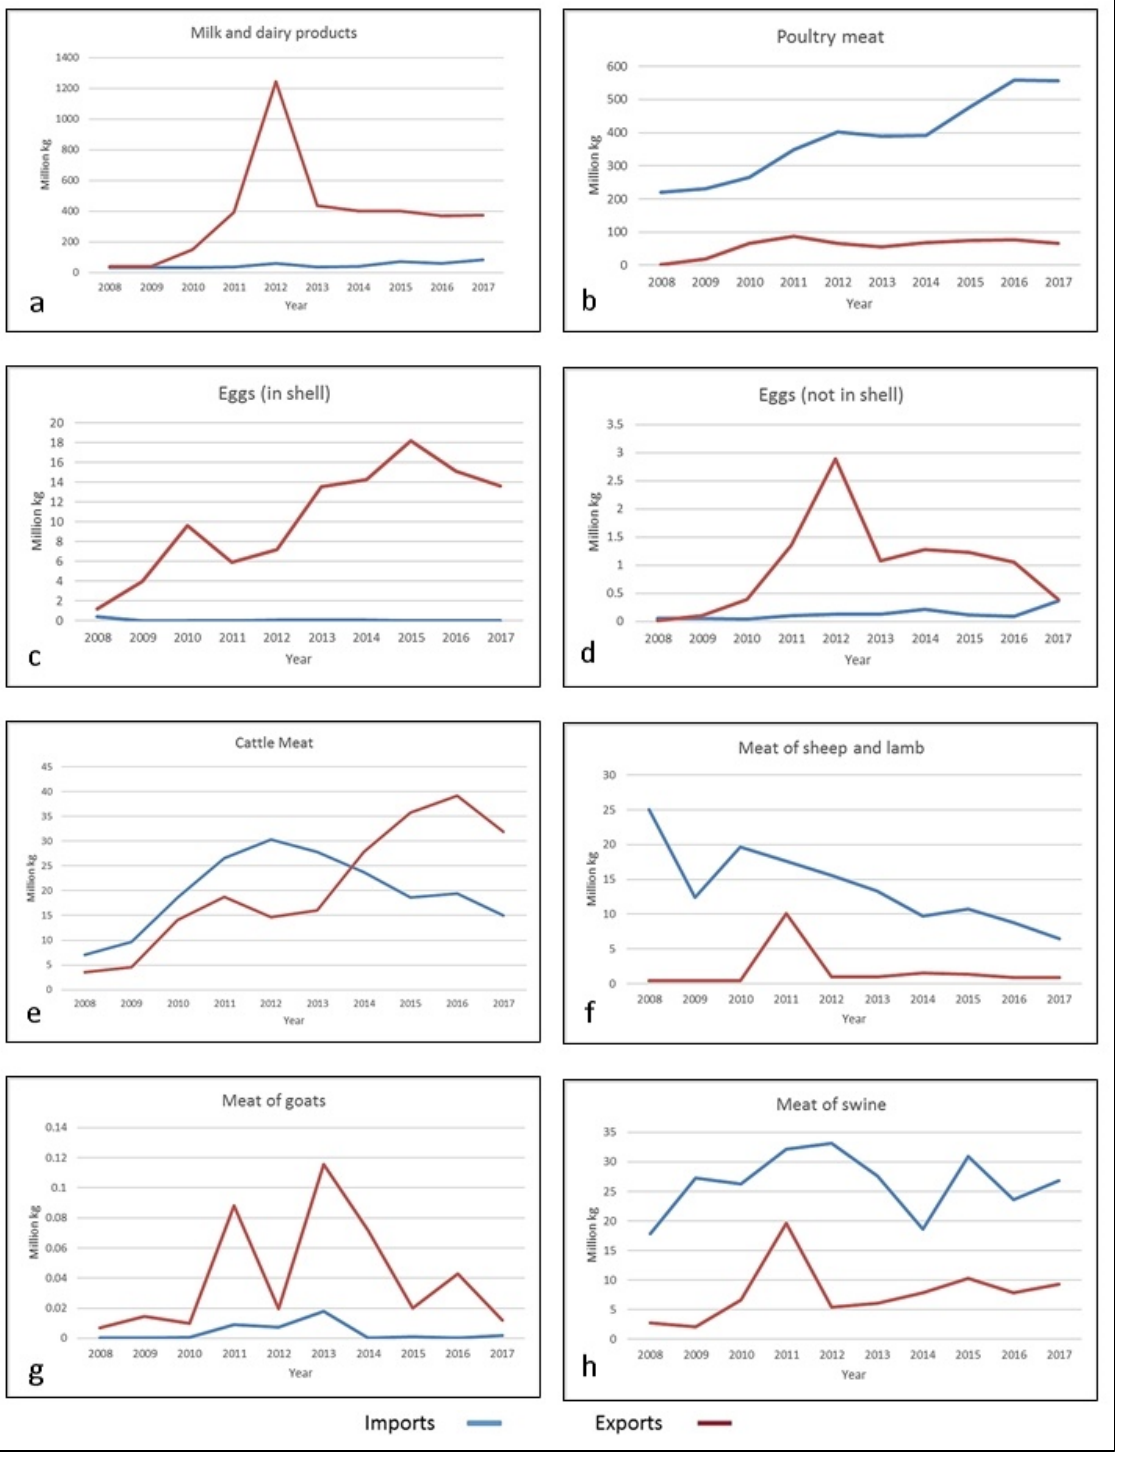
Data source: Quantec Easydata